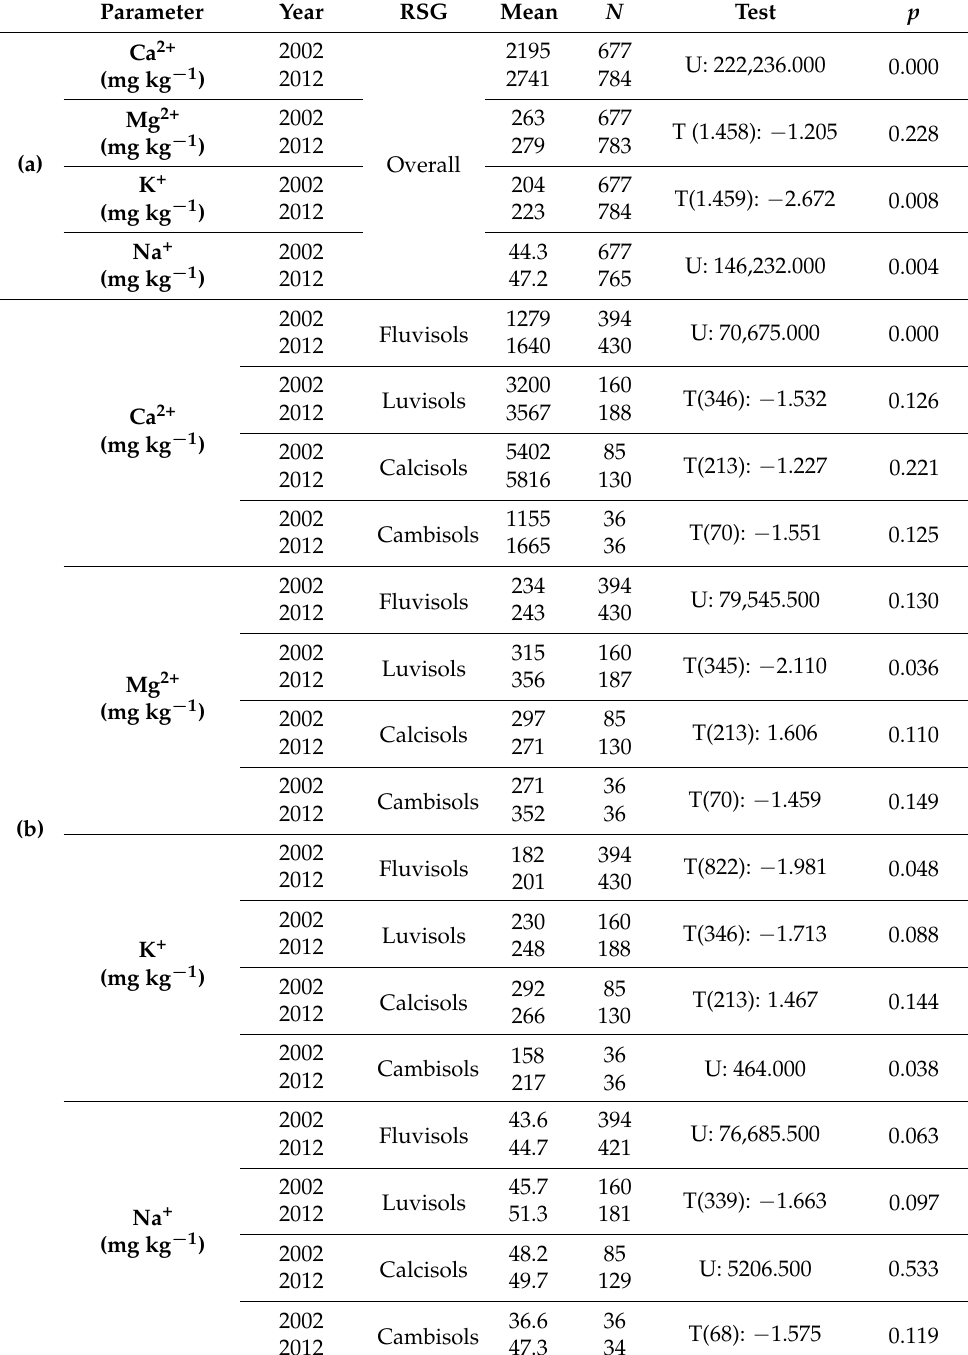
Table 5. Mid-term evolution (2002 to 2012) of selected soil parameters in irrigated